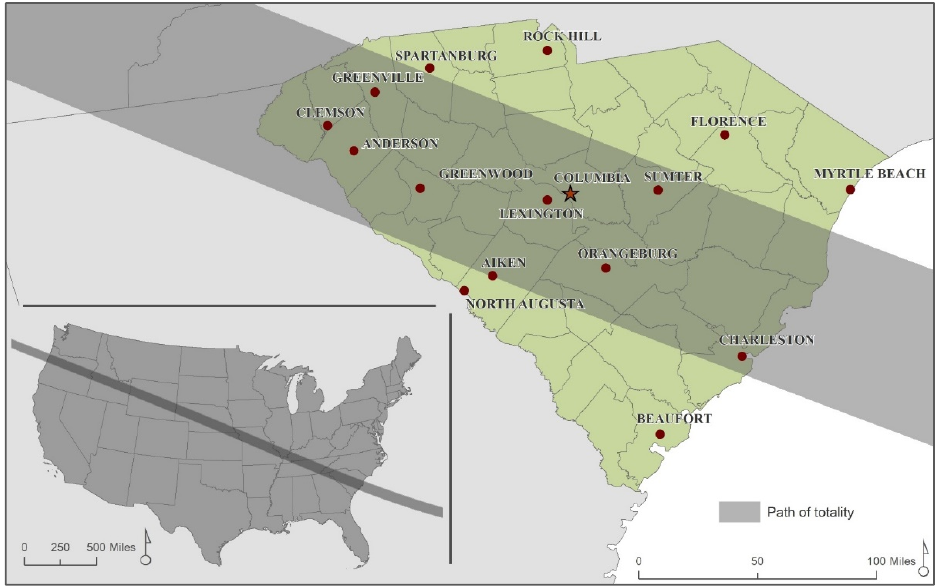
Figure 1. Path of the 2017 Solar Eclipse totality in South Carolina and across the